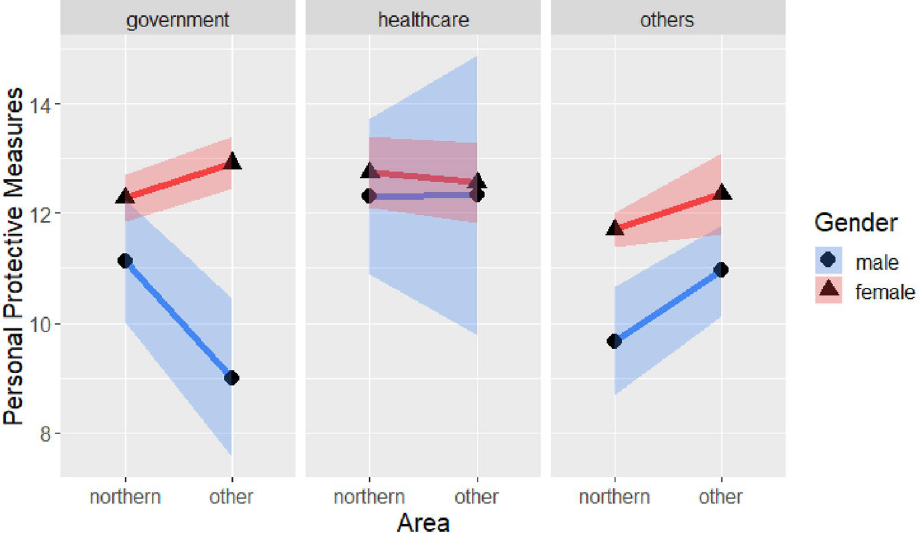
Figure 6. Three-way interaction of personal protective measures with gender, region and